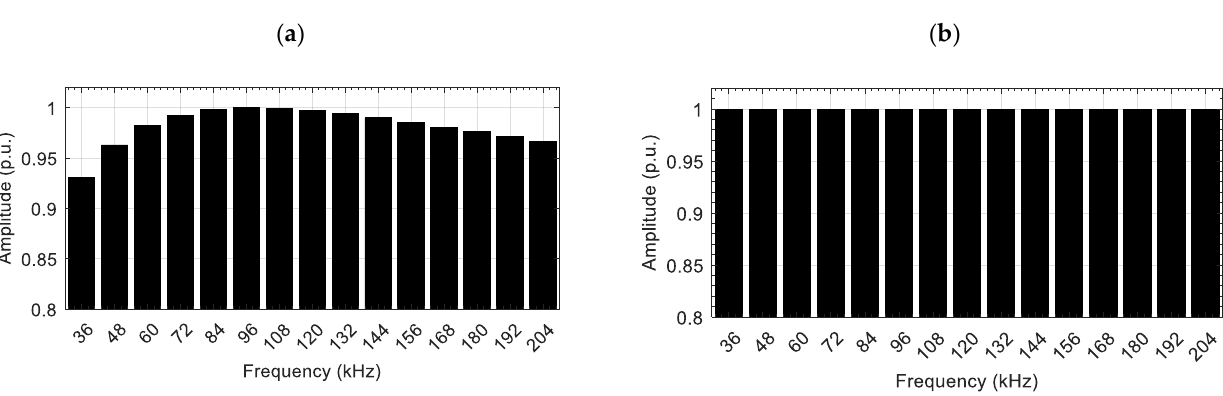
Figure 3. Spectrum comparison for non-normalized ( a ) and normalized ( b ) measured signals.